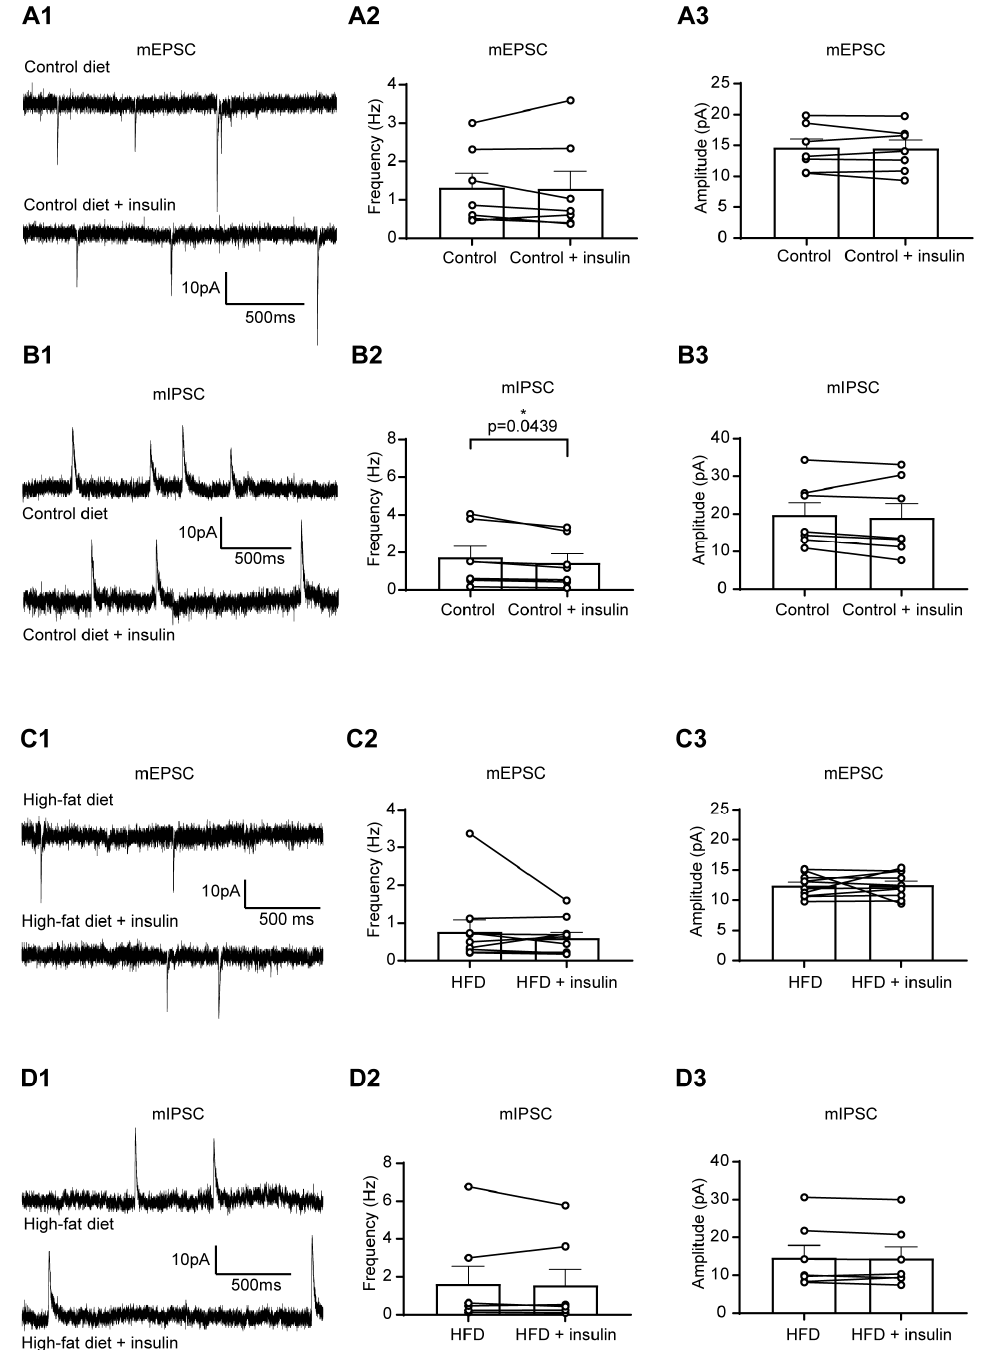
Figure 3. The insulin-dependent suppression of inhibitory neurotransmission is diminished in HFD- fed mice. ( A , B ): Representative traces illustrate the effect of insulin on mEPSCs ( A1 ) and mIPSCs ( B1 ) in control mice. In control mice, insulin did not alter the frequency ( A2 ) and amplitude ( A3 ) of mEPSCs; however, it decreased the frequency ( B2 ) of mIPSCs without altering the amplitude ( B3 ). ( C , D ): Representative traces illustrate the effect of insulin on mEPSCs ( C1 ) and mIPSCs ( D1 ) in HFD- fed mice. In HFD-fed mice, insulin did not alter the frequency and amplitude of mEPSCs ( C2 , C3 ) and mIPSCs ( D2 , D3 ). HFD: high-fed diet, mEPSCs: miniature excitatory post-synaptic currents, mIPSCs: miniature inhibitory post-synaptic currents. Circles and squares represent individual neurons. * p <